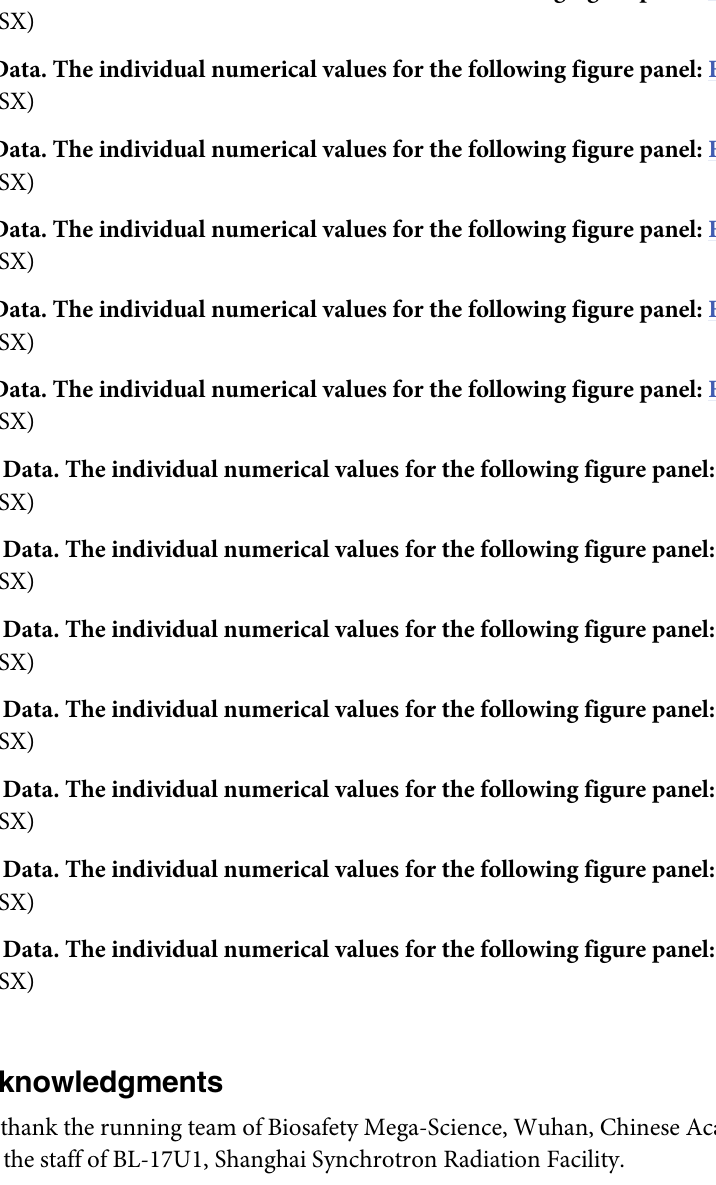
S3 Data. The individual numerical values for the following figure panel: Fig 2A. (XLSX) S4 Data. The individual numerical values for the following figure panel: Fig 2B. (XLSX) S5 Data. The individual numerical values for the following figure panel: Fig 2C. (XLSX) S6 Data. The individual numerical values for the following figure panel: Fig 2D. (XLSX) S7 Data. The individual numerical values for the following figure panel: Fig 2E. (XLSX) S8 Data. The individual numerical values for the following figure panel: Fig 2F. S9 Data. The individual numerical values for the following figure panel: Fig 5. S10 Data. The individual numerical values for the following figure panel: Fig 5C. S11 Data. The individual numerical values for the following figure panel: S3A Fig. S12 Data. The individual numerical values for the following figure panel: S3B Fig. S13 Data. The individual numerical values for the following figure panel: S4 Fig. S14 Data. The individual numerical values for the following figure panel: S5B Fig. S15 Data. The individual numerical values for the following figure panel: S5C Fig. S16 Data. The individual numerical values for the following figure panel: S6 Fig.